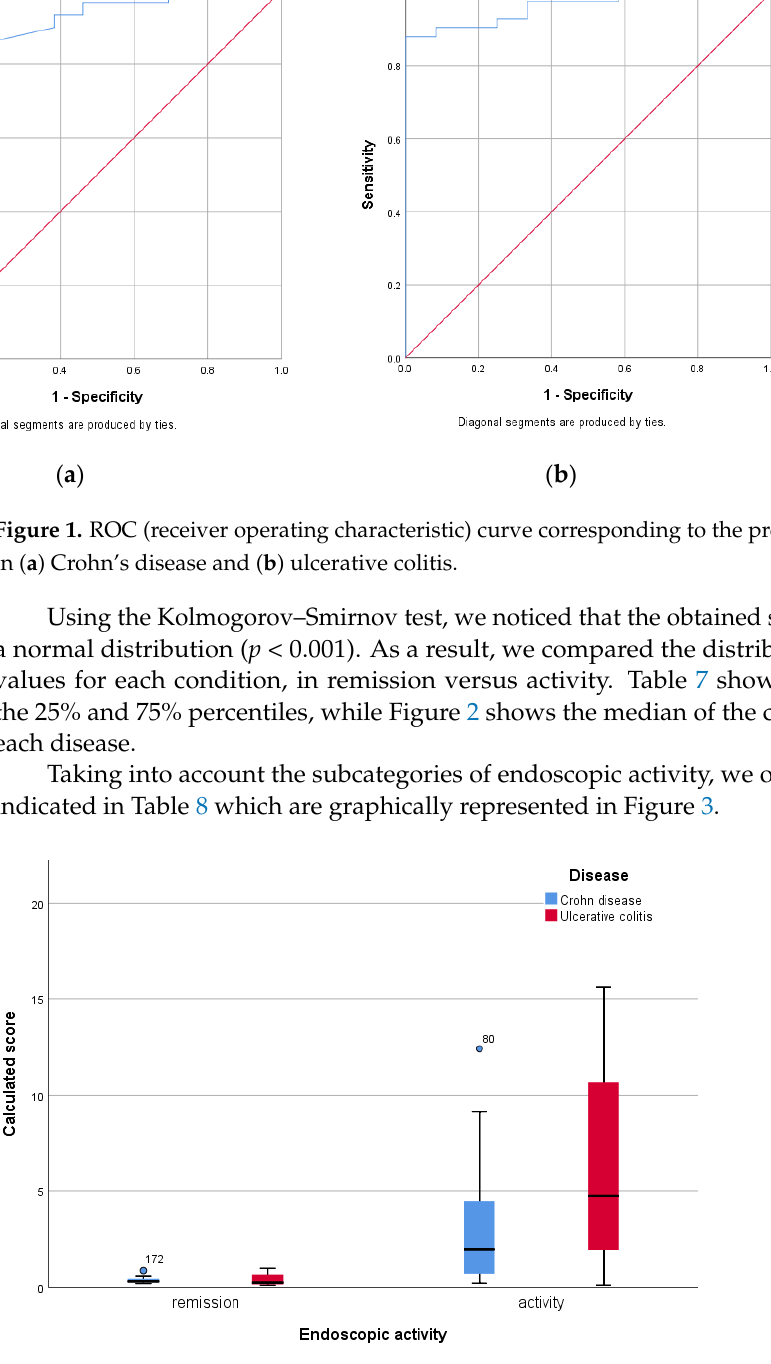
Figure 2. Median values of the activity score calculated according to the degree of endoscopic activity, for each of the studied conditions ( ◦ mild outlier). Table 7. Description of the activity score according to the degree of endoscopic activity.